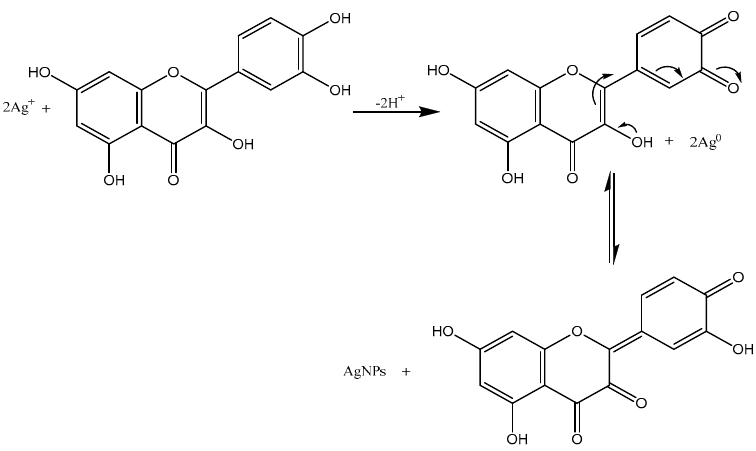
Figure 1. Mechanism of Ag + ion reduction to silver nanoparticles (AgNPs) by quercetin.